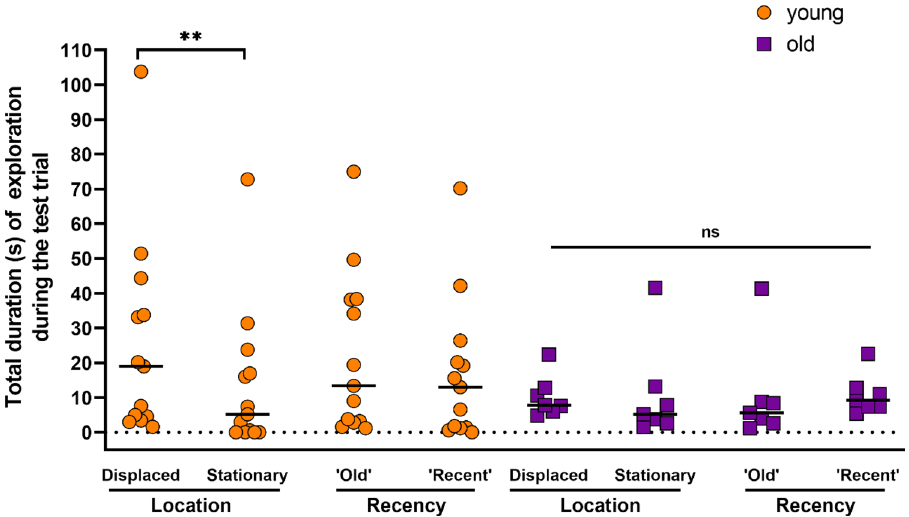
Figure 2. Exploratory behaviour during the test trial. Total time of exploration (duration in seconds), by the different groups (young individuals (Orange filled circle); old (Purple filled square) given by the sum of the different objects (displaced vs. stationary for location memory; and ‘old’ vs. ‘recent, for recency memory’) during the test trial. Individual values are shown. The horizontal line represents the group median ( ** P < 0.01, ns: not significant).